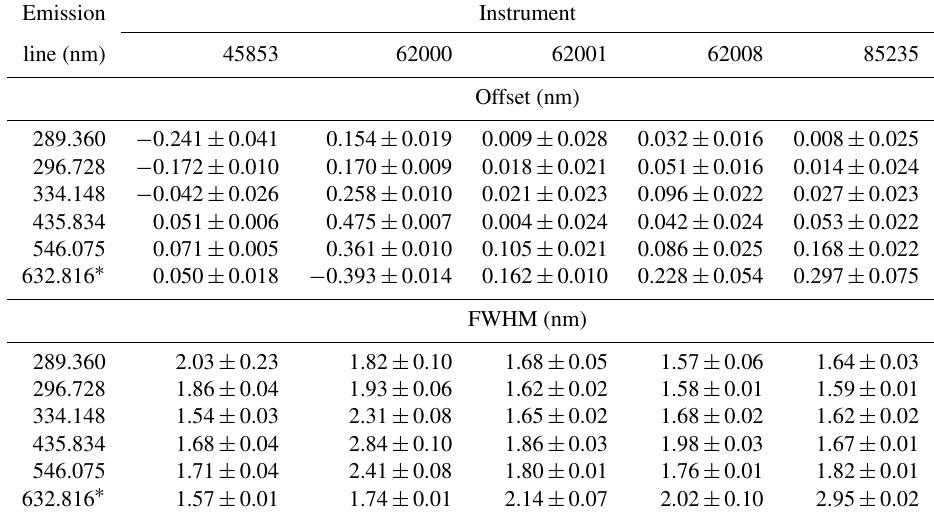
Table 1. Wavelength offsets and slit function half widths (FWHM) of spectroradiometers obtained by fitting Eq. (4) to Hg emission lines of a low-pressure mercury lamp. Dependent on instrument, uncertainties correspond to standard deviations from 3 to 13 measurements during 3–9-year periods. Data at 632.8nm were obtained with a HeNe laser instead of a mercury lamp (2–3 measurements during a 3-year period). Examples of emission line fits are shown in Fig. 2.